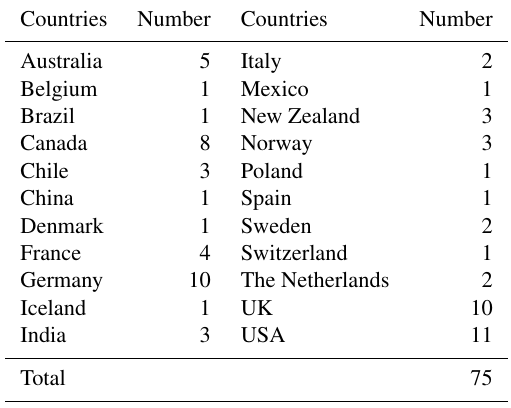
Table 1. Number of participants and their countries of origin (in- cluding the project leaders); see also Fig. 1a.